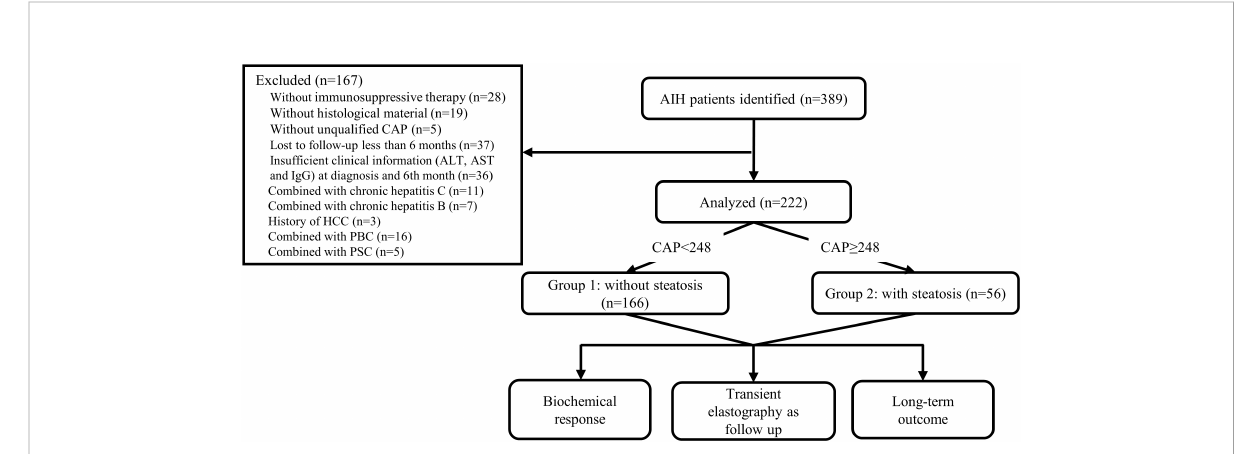
FIGURE 1 Flowchart of the study. AIH autoimmune hepatitis, CAP controlled attenuation parameter, ALT alanine aminotransferase, AST aspartate aminotransferase, IgG immunoglobulin G, HCC hepatocellular carcinoma, PBC primary biliary cirrhosis, PSC primary sclerosing